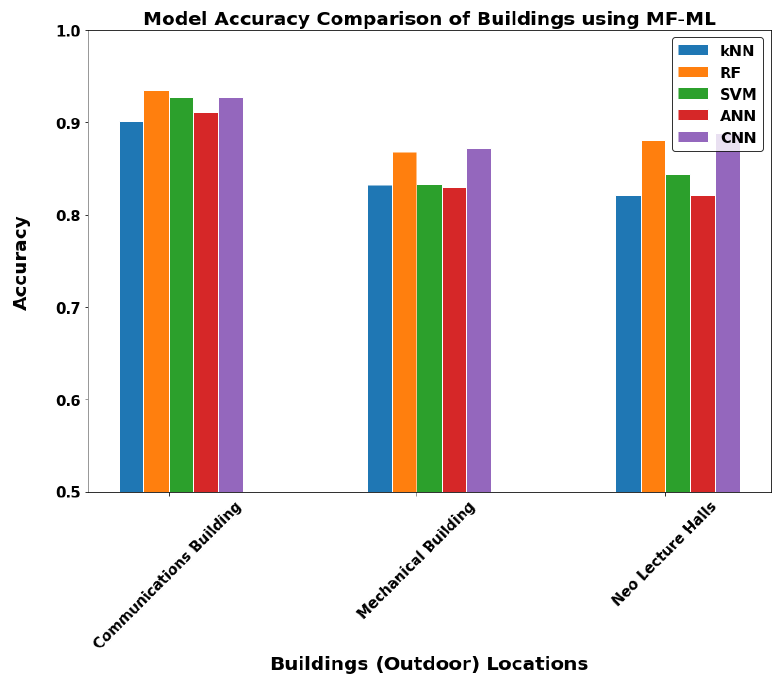
Figure 19. The models accuracy in all outdoor buildings geofences using MF-ML. Table 1. WRL Lab Indoor WF-ML results.